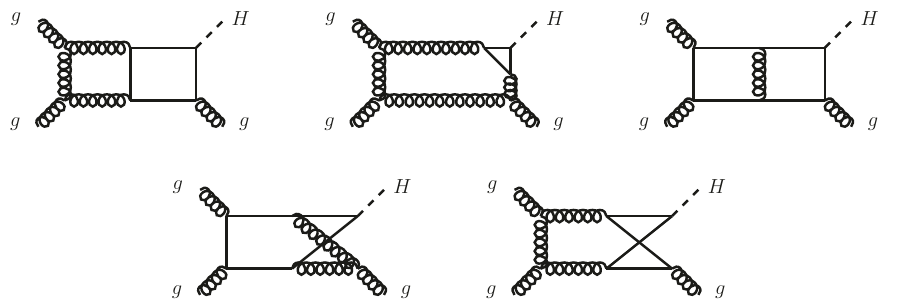
Figure 2 . Examples of two-loop Feynman diagrams that contribute to the process gg ! Hg .